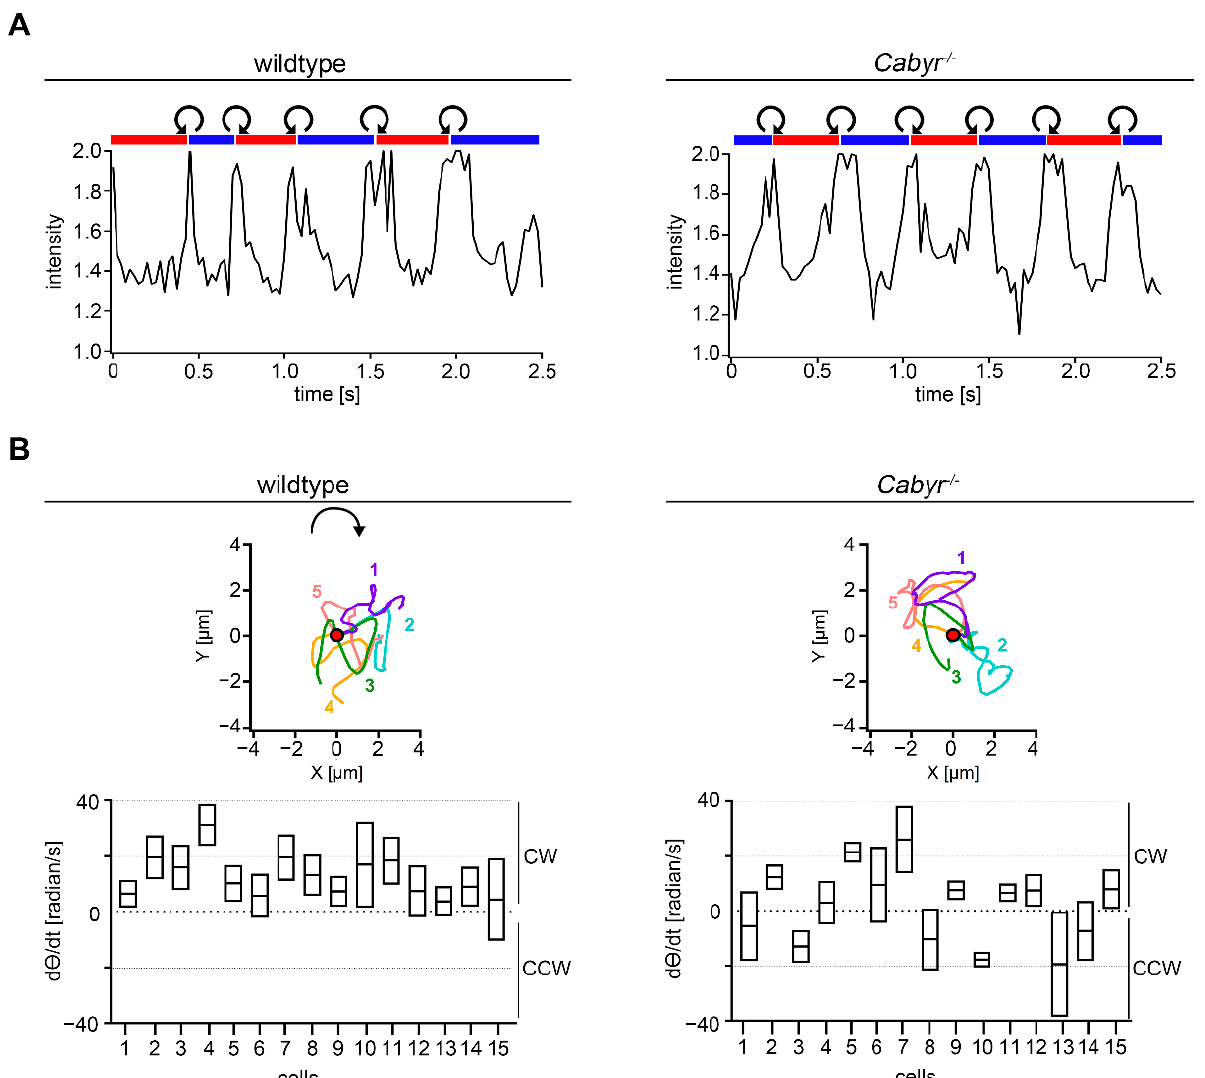
Figure 7. Cabyr facilitates conserved CW path chirality. ( A ) Analysis of rolling behavior along the long axis of wt (left panel) or Cabyr − / − (right panel) sperm during a time interval of 2.5 s. Red and blue bars indicate periods of “RCh” and “LCh” orientation for the sperm head. The short white areas represent an indeterminate orientation and the curved arrows indicate CW or CCW rolling. In the diagram, the oscillating light intensity, which is scattered from the sperm head, is shown. Cabyr − / − sperm show a comparable rolling behavior as wt sperm. ( B ) Averaged Procrustes alignments of five representative wt (upper, left) or five Cabyr − / − sperm (upper, right) translocated to place the initial point at the origin. The curved arrow indicates a CW path chirality analyzed by visual assessment. Determined d θ /dt (mean ± SEM) for 15 wt (lower, left) and 15 Cabyr − / − sperm (lower, right). Positive d θ /dt values indicate a CW and negative values a CCW path chirality. CABYR facilitates conserved CW path chirality.